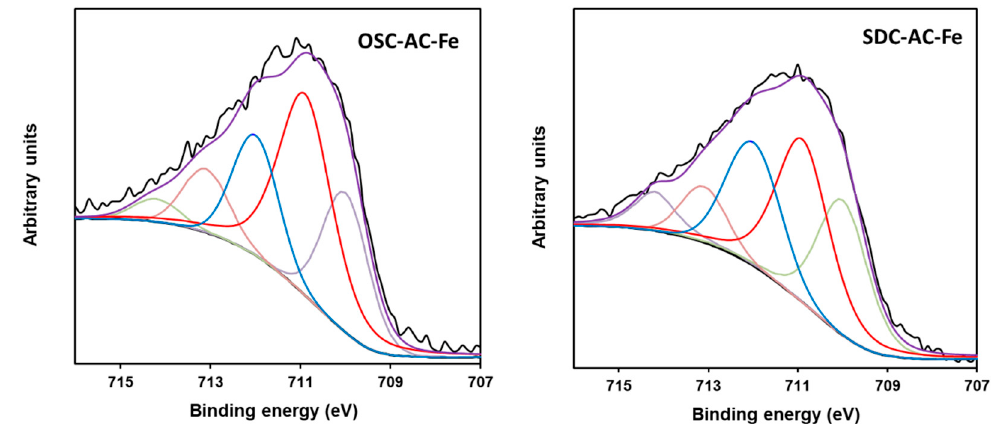
Figure 9. Fitting of the 2p 3/2 spectral region of OSC-AC-Fe and SDC-AC-Fe samples.